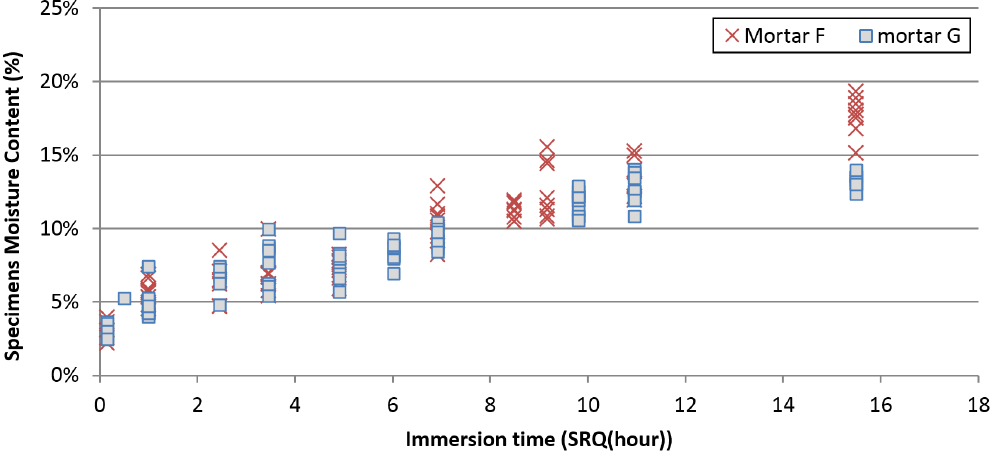
Figure 5. Moisture variation versus immersion time along 10 days.